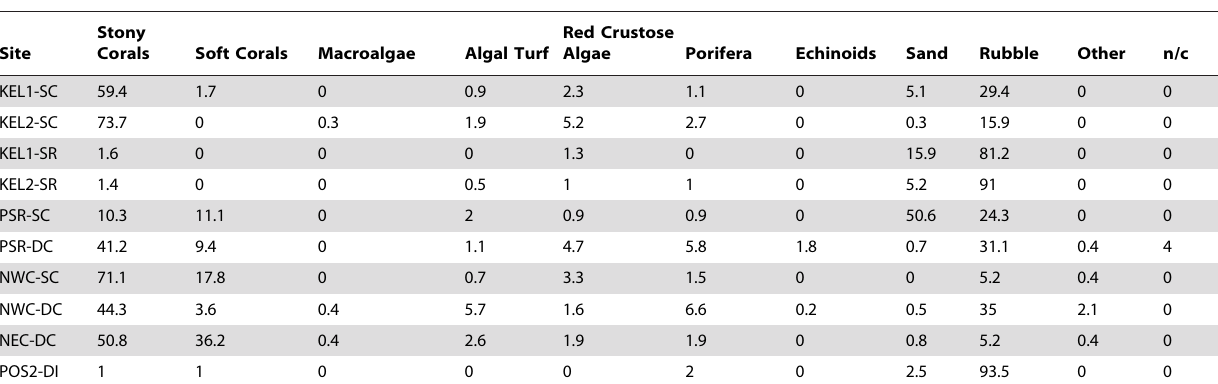
Table 2. Percent cover of functional